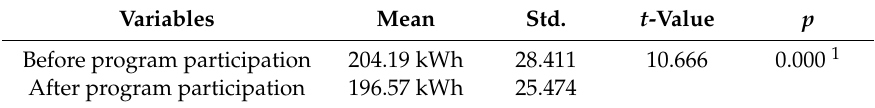
Table 4. Comparison of Home Energy Saving Rate Before and After Program Participation.